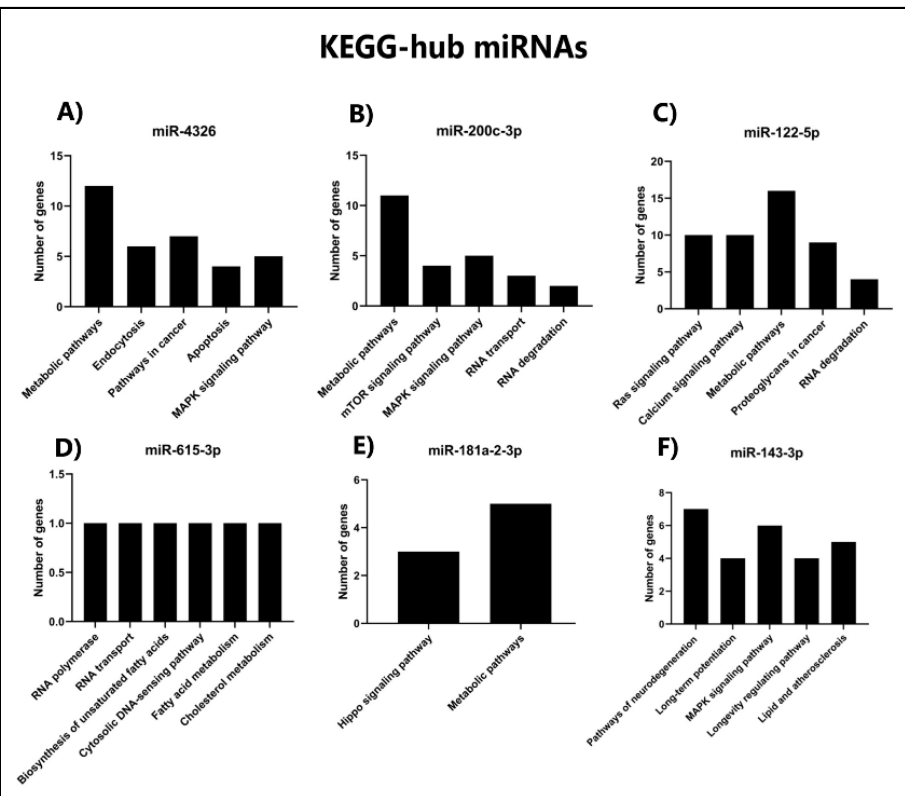
Figure 6. KEGG enrichment analysis of target genes from hub miRNAs. Upregulated miRNAs, ( A ) miR-4326, ( B ) miR-200c-3p, ( C ) miR-122-5p; downregulated miRNAs, ( D ) miR-615-3p ( E ), miR-181a-2-3p, and ( F ) miR-143-3p. The x -axis shows pathway names, and the y -axis indicates the number of target genes.